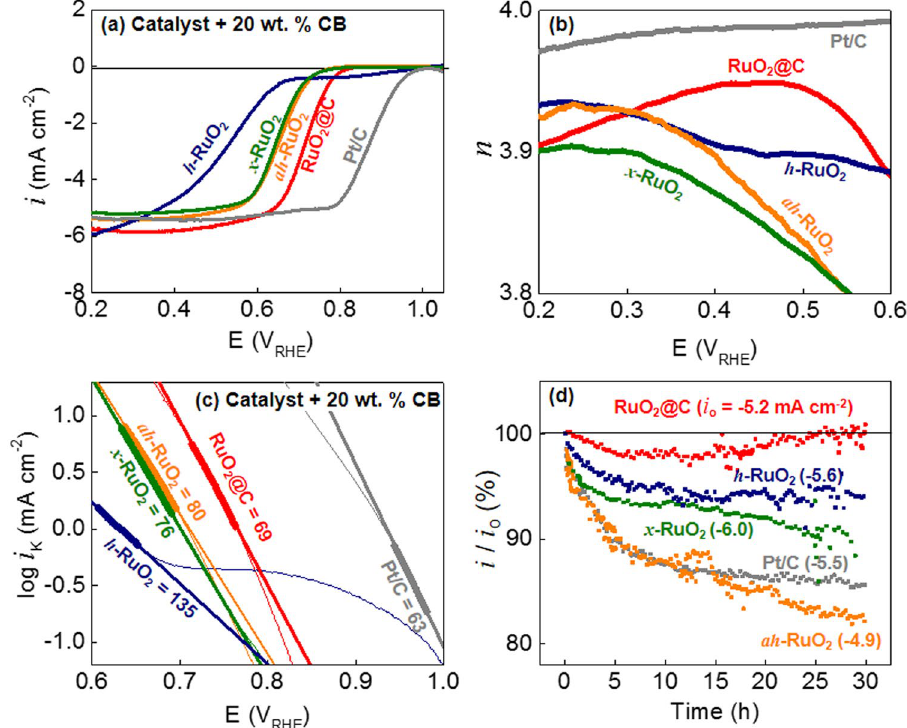
Figure 3. ORR in O 2 -saturated 0.1 M KOH (aq). ( a ) ORR polarization curves at 1,600 rpm and 10 mV s − 1 . ( b ) Electron transfer number ( n ). ( c ) Tafel plots. Mass transfer-corrected currents ( i K ) are used. Tafel slopes (b) are indicated in mV dec − 1 . ( d ) Chronoamperometric stability of ORR at + 0.4 V RHE . The initial currents are indicated next to the names of the